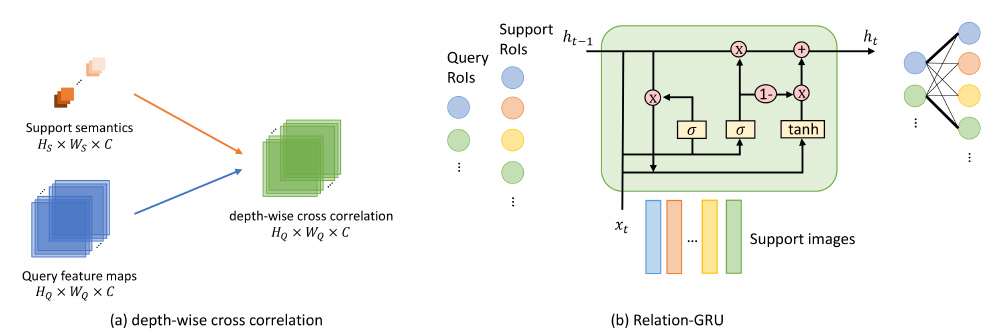
Figure 13. The principle of deep-wise cross correlation and relation-GRU. ( a ) For every channel, a convolu- tion procedure is implemented where the convolutional kernel is the corresponding channel of the support semantics. Deep-wise cross-correlation is equivalent to channel-wise multiplication when H S = W S = 1, and is also equivalent to element-wise multiplication when H S = H Q , W S = W Q . ( b ) The green block refers to relation-GRU. h is the RoIs from detection framework, the left column belongs to query images and the right column refers to support